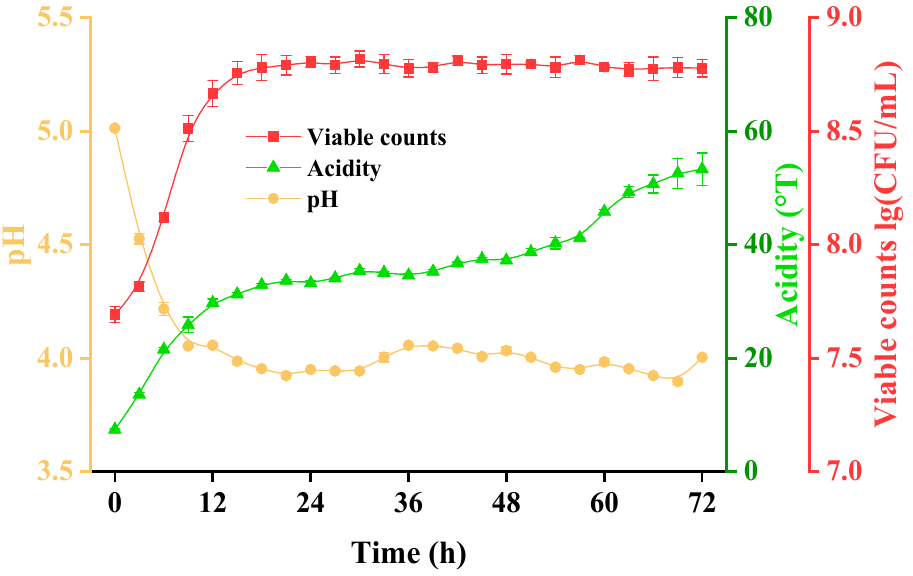
Figure 2. Dynamic changes in pH, acidity and the number of living bacteria during the fermentation of SHLE by L. fermentum grx08 for 72 h.